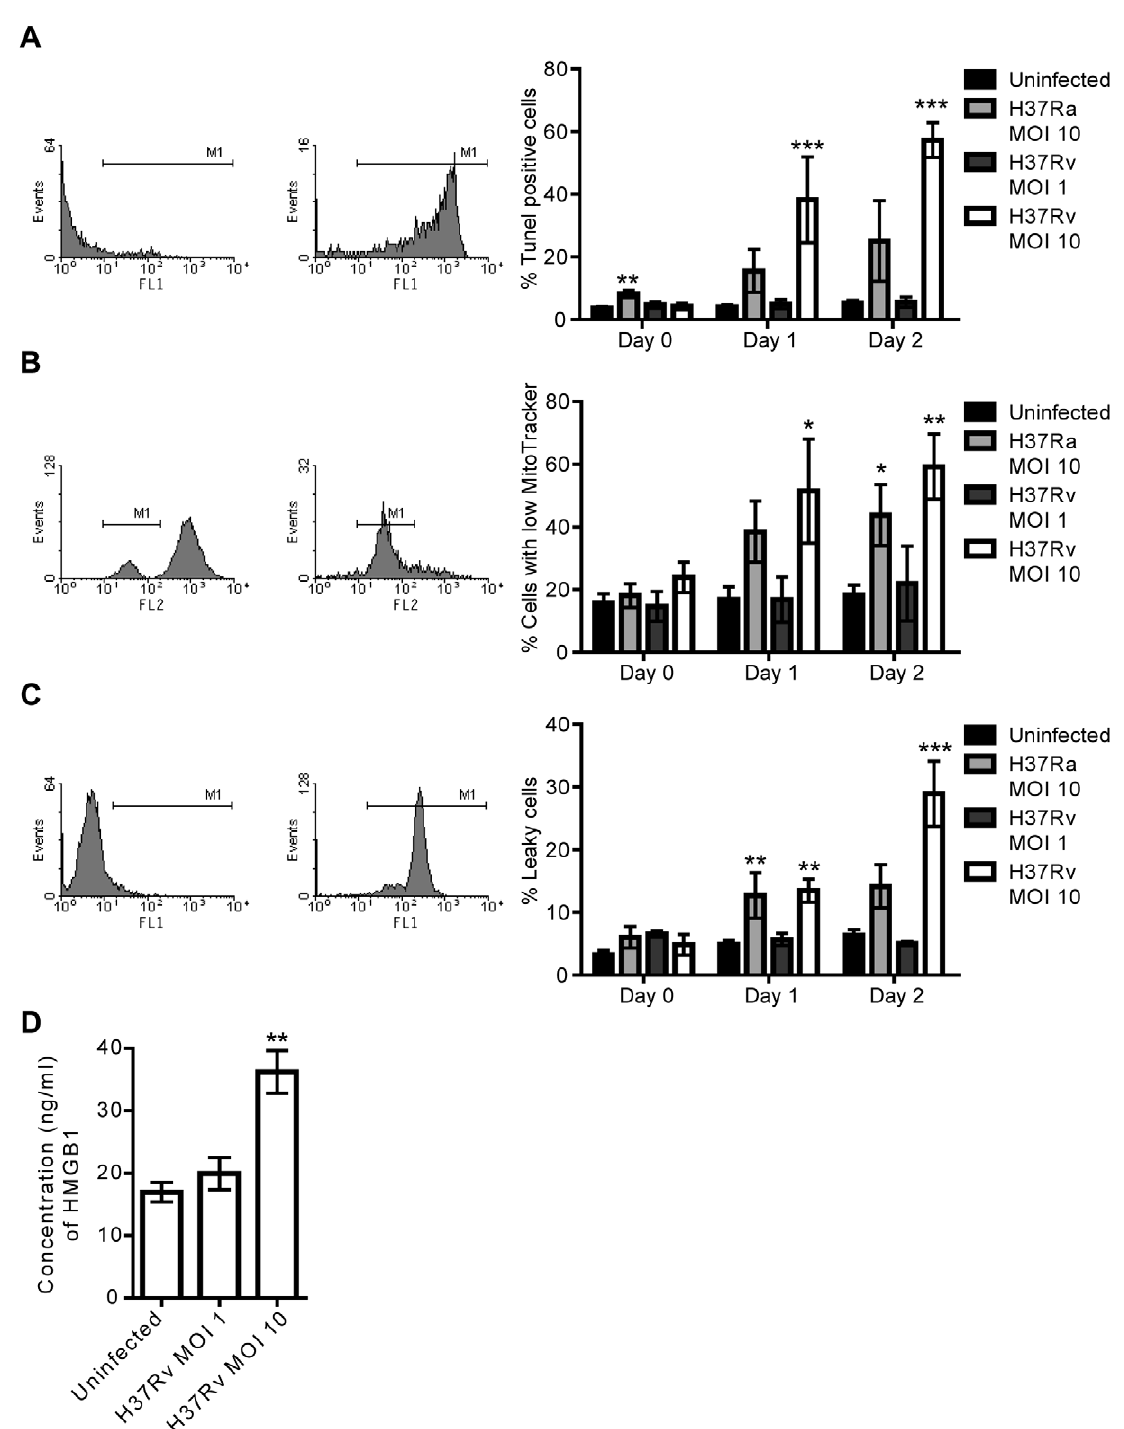
Figure 3. Features of cell death induced by Mtb. hMDMs were left uninfected, or infected with H37Rv at MOI 1 or 10, or H37Ra at MOI 10 over two days. Three different staining procedures were used to investigate cell death features on each day, and the cells were analyzed by flow cytometry. A ) TUNEL analysis of DNA fragmentation. The first histogram shows representative flow cytometry data for hMDMs negative for TUNEL staining (untreated), and the second one for hMDMs positive for TUNEL staining (DNase-treated). The bar graph shows the percentage of hMDMs that were positive for TUNEL staining in uninfected or infected samples over two days (n $ 5). B ) MitoTracker analysis of mitochondrial membrane potential loss. The first histogram shows representative flow cytometry data for hMDMs with high MitoTracker staining (untreated), and the second one for hMDMs with low MitoTracker staining (UV-treated). The bar graph shows the percentage of hMDMs that had low MitoTracker staining (i.e. compromised mitochondria) in uninfected or infected samples over two days (n $ 3). C ) Plasma membrane integrity analysis. The first histogram shows representative flow cytometry data for hMDMs negative for plasma membrane leakiness staining (untreated), and the second one for hMDMs positive for plasma membrane leakiness staining (heat-treated). The bar graph shows the percentage of hMDMs that were positive for plasma